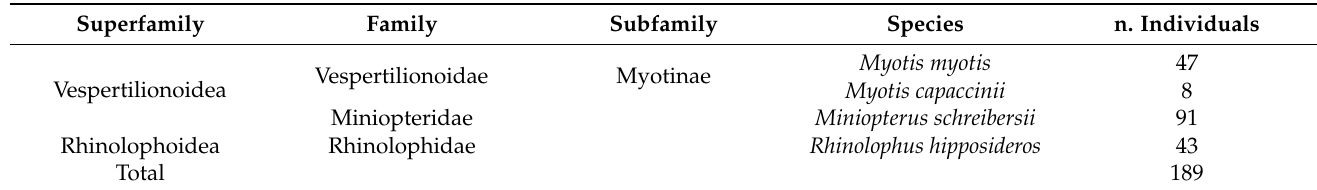
Table 1. Individuals